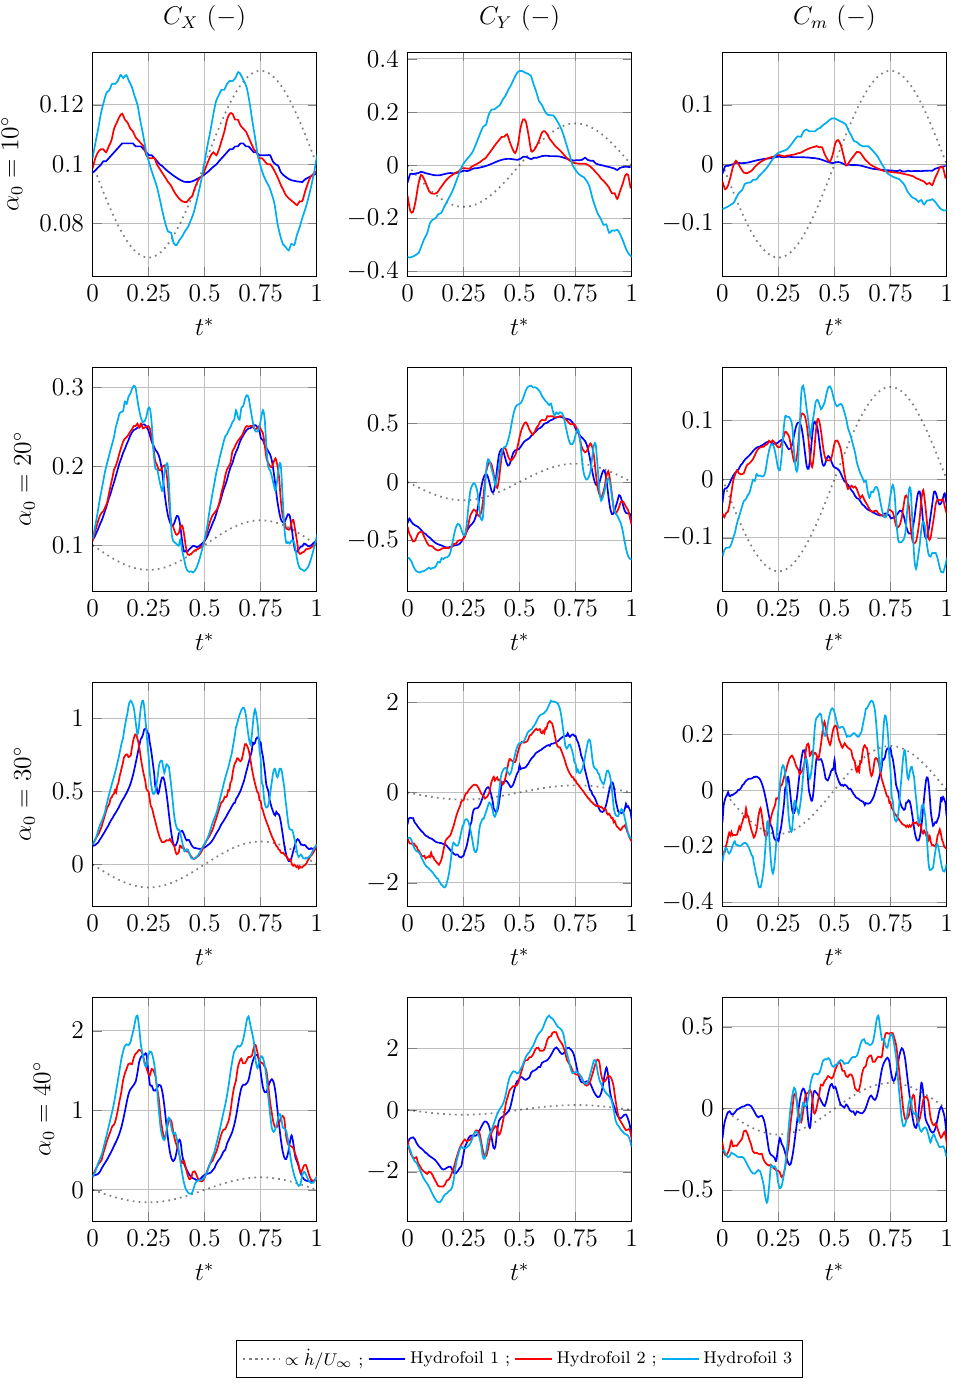
Figure 8. Hydrodynamic coefficients C Y , C M , and C X and hydrofoil vertical velocity ˙ h / U ∞ versus time, for α 0 = 10 ◦ , 20 ◦ , 30 ◦ , and 40 ◦ and f ∗ = 0.025, ∆ h = 0.8 m and for the three